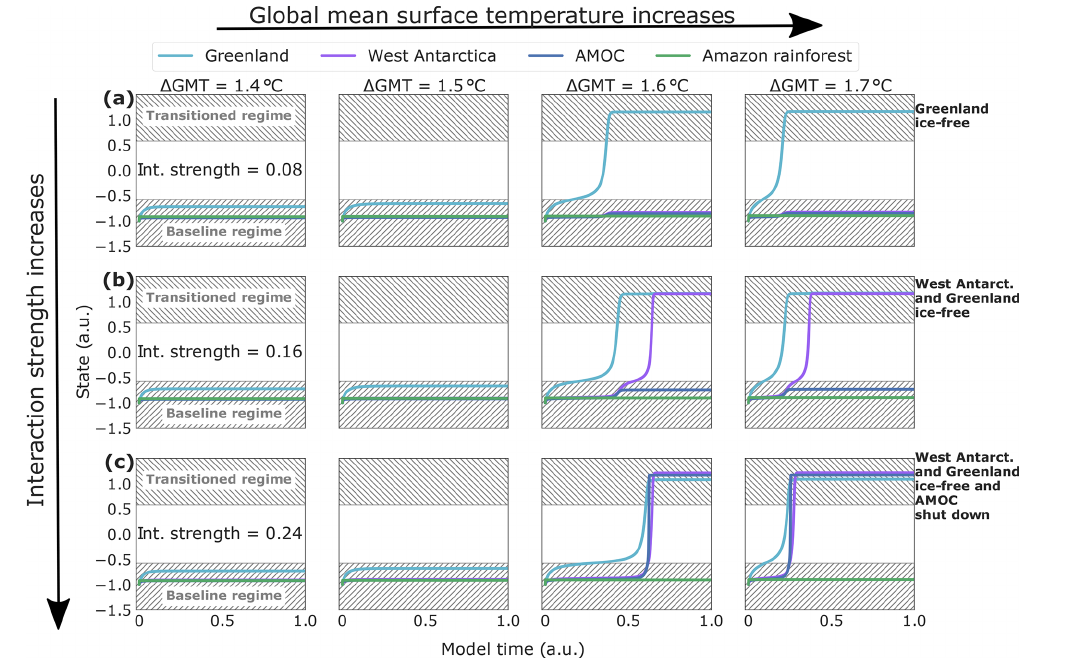
Figure 3. Time series of tipping cascades. Exemplary time series of states for each of the four investigated tipping elements, simulated here until equilibrium is reached. For comparability reasons, the parameter settings for the time series are the same (exact parameters can be found in Table S1), and all time series are computed for (cid:49) GMT increases of 1.4, 1.5, 1.6 and 1.7 ◦ C above pre-industrial (columns). Couplings are constant for each row. Tipping cascades as shown here are defined as the number of transitioned elements at a fixed interaction strength and (cid:49) GMT compared to the simulation with a slightly higher (cid:49) GMT ( (cid:49) GMT increase by 0.1 ◦ C) but same interaction strength. If, between these two simulations, some of the tipping elements alter their equilibrium state, a tipping cascade of the respective size occurred and is counted as such. (a) A single tipping event for an interaction strength of 0.08. Tipping occurs at 1.6 ◦ C. (b) A tipping cascade with two elements for an interaction strength of 0.16. (c) A tipping cascade with three elements for an interaction strength of 0.24. For other initial conditions, interaction strengths and global mean surface temperatures ( (cid:49) GMT) tipping cascades with four elements can occur too. Additionally, we marked the baseline and the transitioned regime as grey hatched areas. Between the hatched areas, the state is not stable, and a critical state transition occurs. In the lower grey area, the element is said to be in the baseline regime, and in the upper grey region, the element is said to be in the transitioned